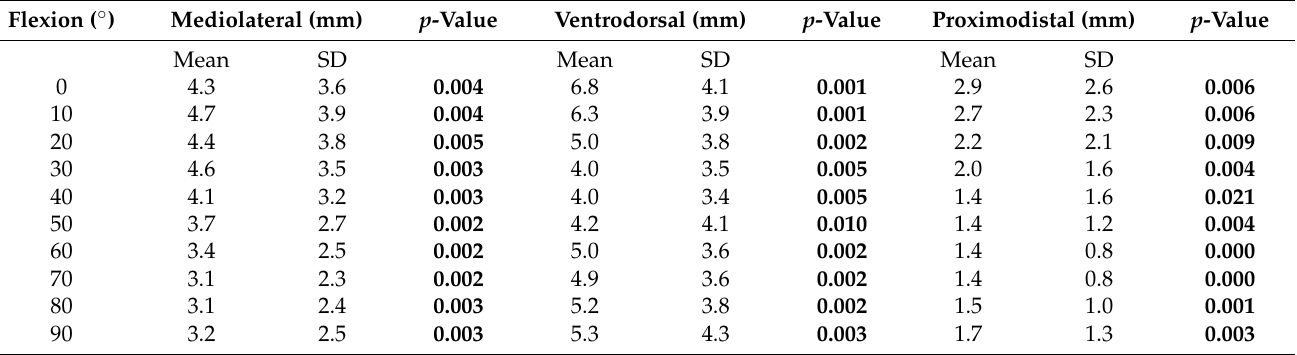
Table 3. Absolute shift in the medial epicondyle after total knee arthroplasty (TKA). Absolute shifts in the medial epicondyle (mediolaterally, ventrodorsally, and proximodistally) after TKA are shown in millimetres (means with standard deviations (SD)) every 10 ◦ of flexion. Bold characters mark significant differences ( p <